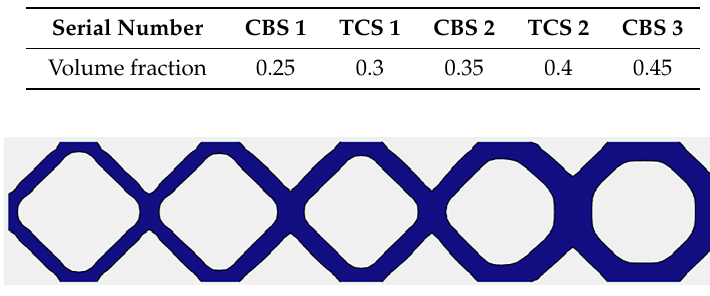
Table 1. Volume fraction of each cellular structure in Figure 4 (from left to right).